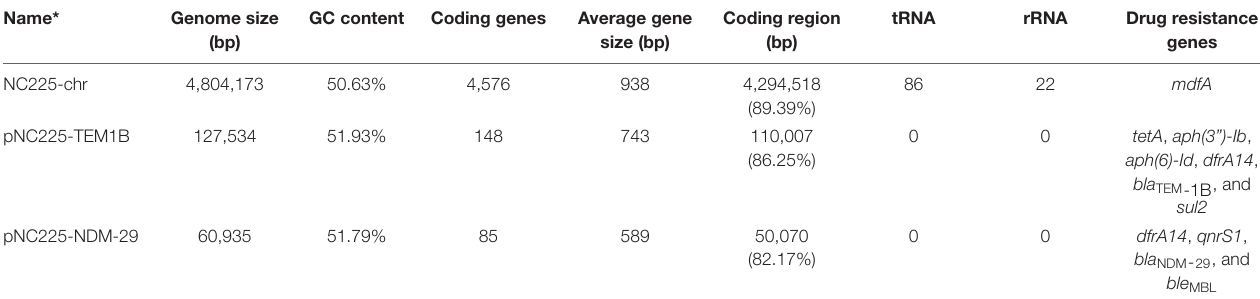
TABLE 3 | The genomic characteristics and antimicrobial resistance genotype analysis of the sequences of chromosomes and plasmids of 19NC225.